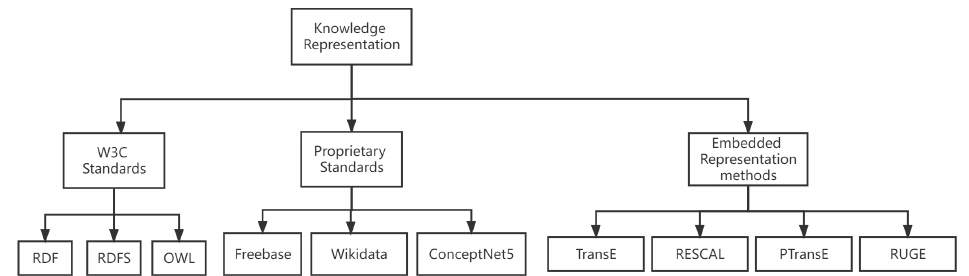
Figure 2. Categorization of knowledge representation methods.